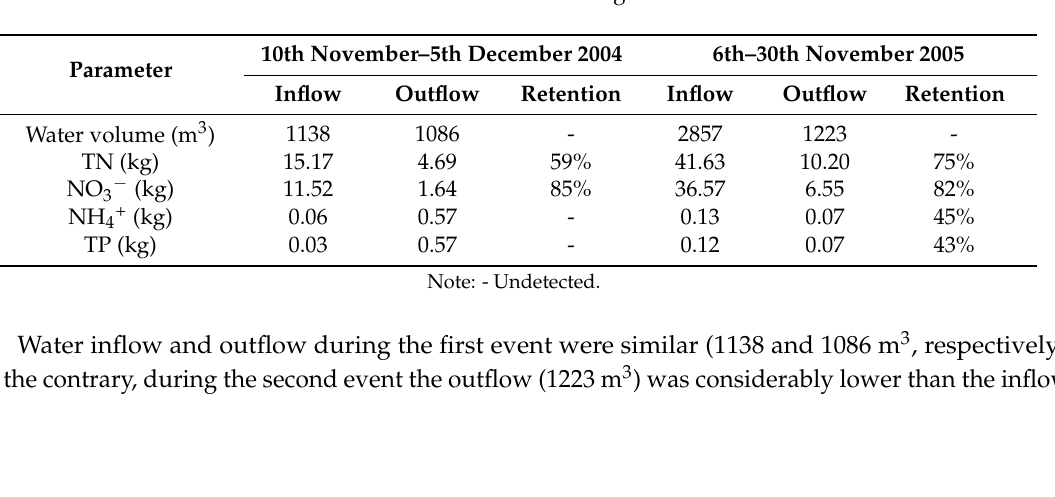
Table 3. Water and nutrient balance during two different